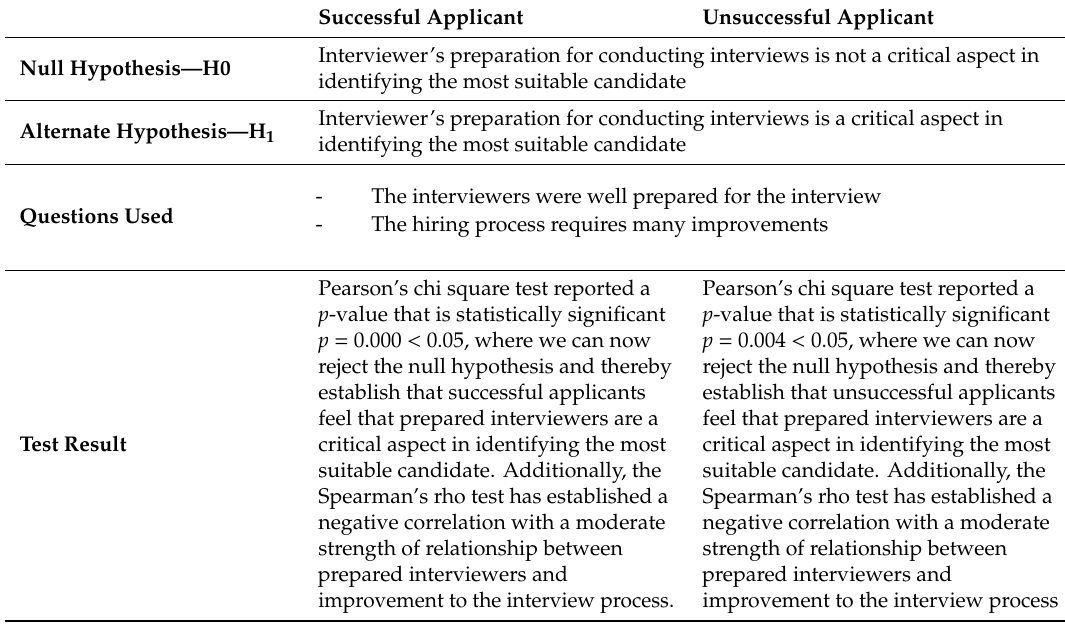
Table 7. Applicant Perspective Hypothesis 5—Interviewer’s preparation.